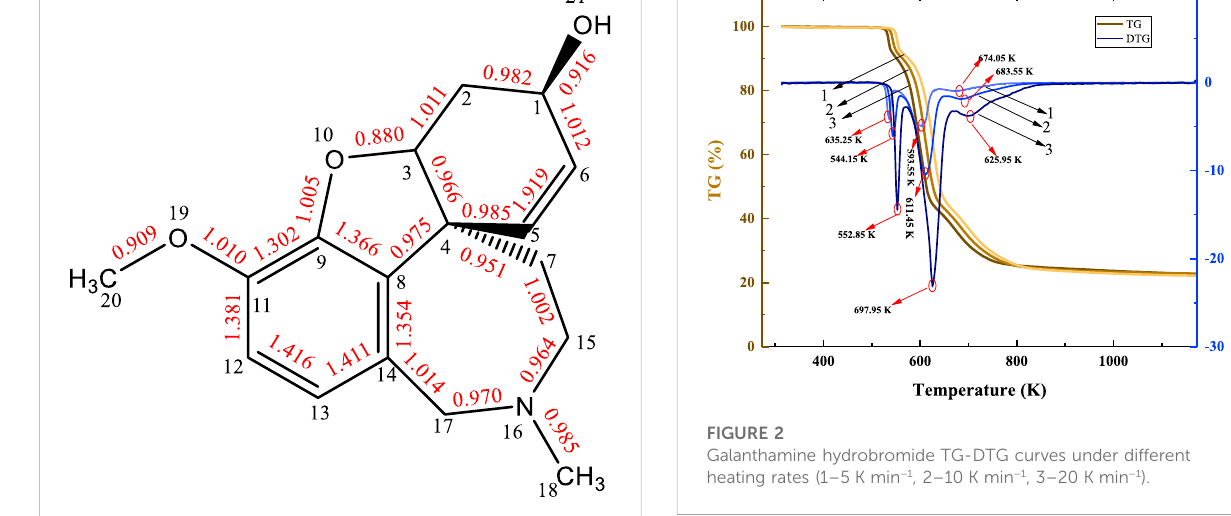
FIGURE 1 Molecular bond orders of galanthamine.